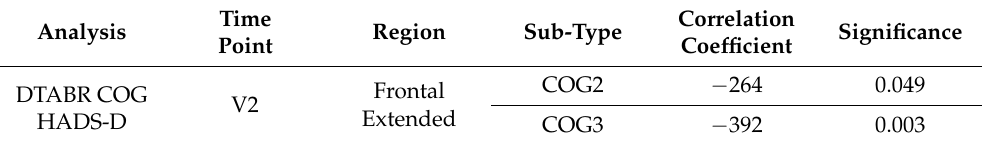
Table 4. Significant correlations at V2.